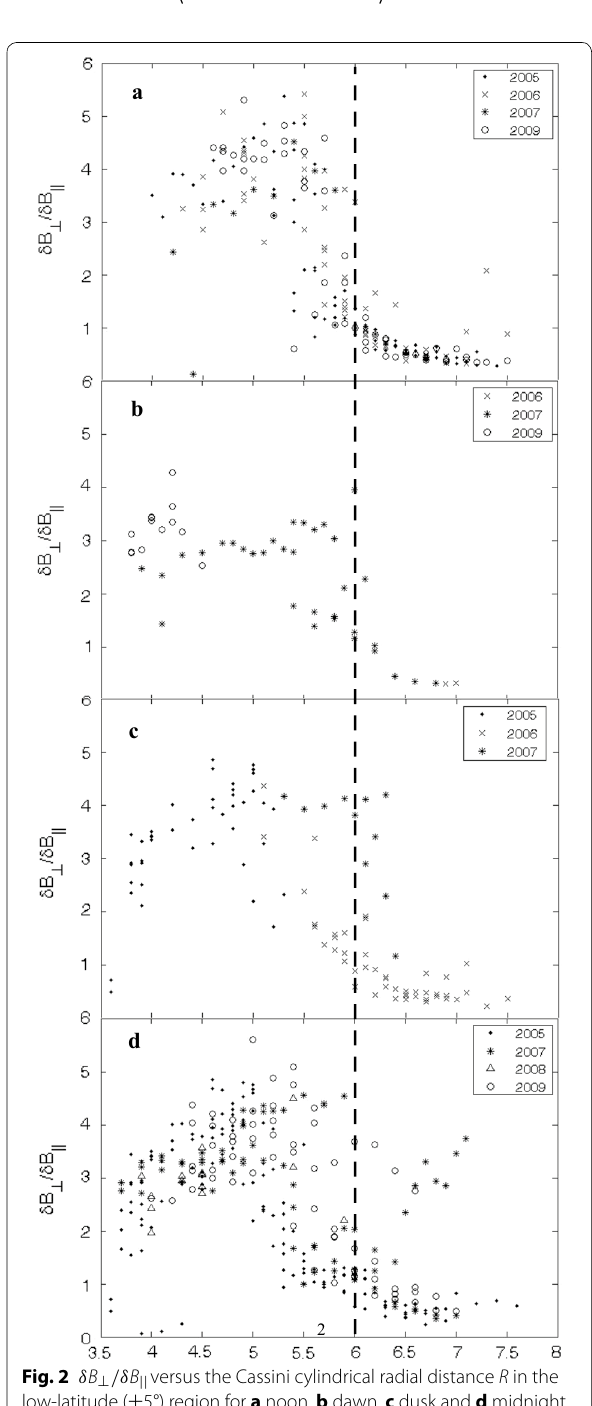
/δ B Fig. 2 δ B versus the Cassini cylindrical radial distance R in the ⊥ || low-latitude ( 5°) region for a noon, b dawn, c dusk and d midnight ± sectors. Each dot represents the averaged value within a radial dis- tance of Δ R 0.2 R S for each =